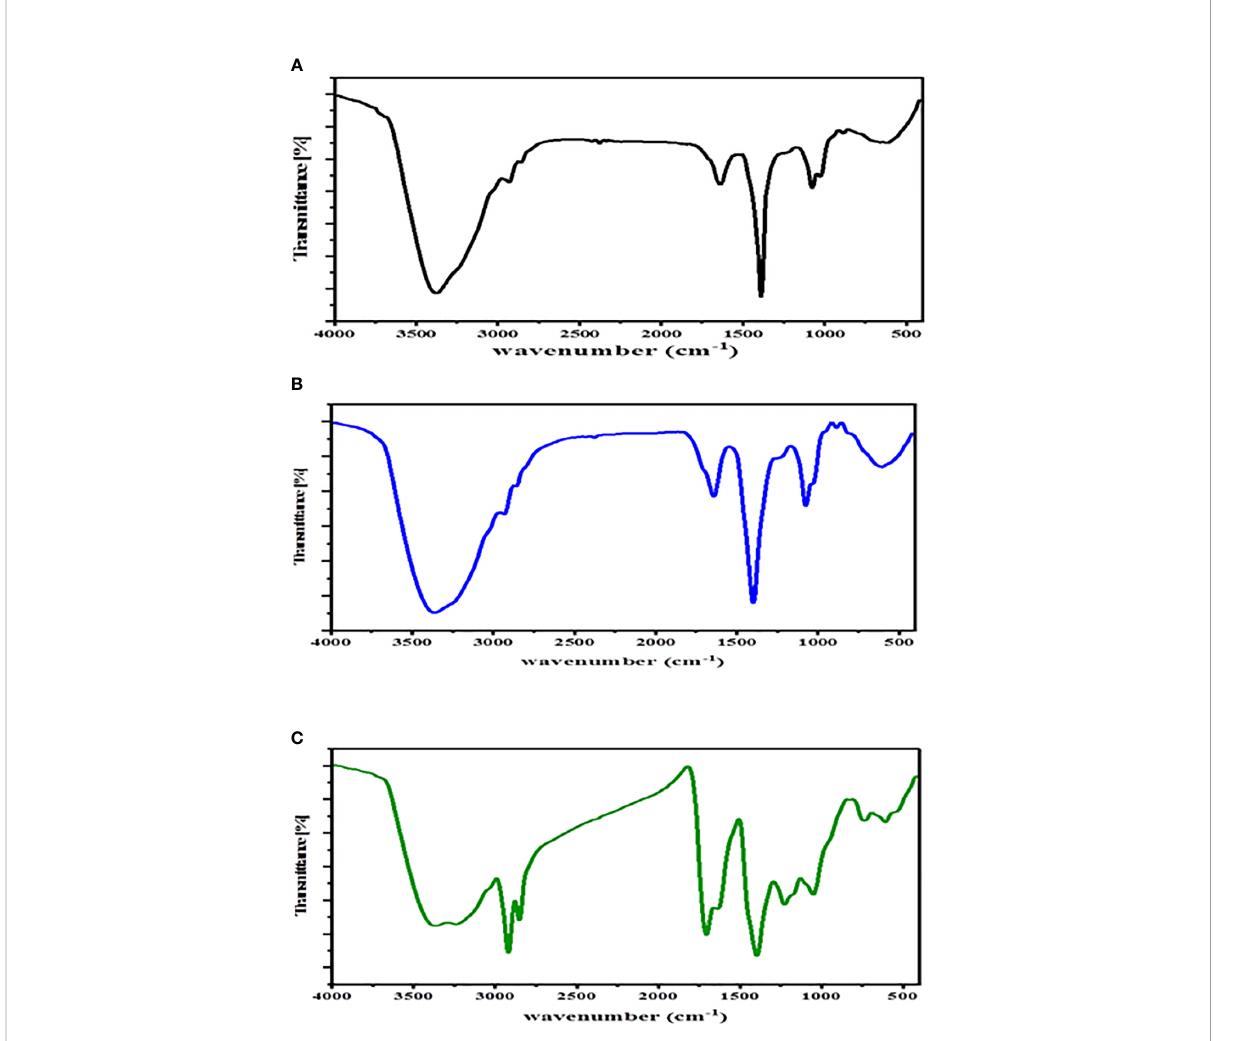
FIGURE 5 FT-IR spectrum of Au-NPs biosynthesized using ethanolic extracts of macroalgae (A) C. myrica , (B) C. trinodis , and (C) C. prolifera